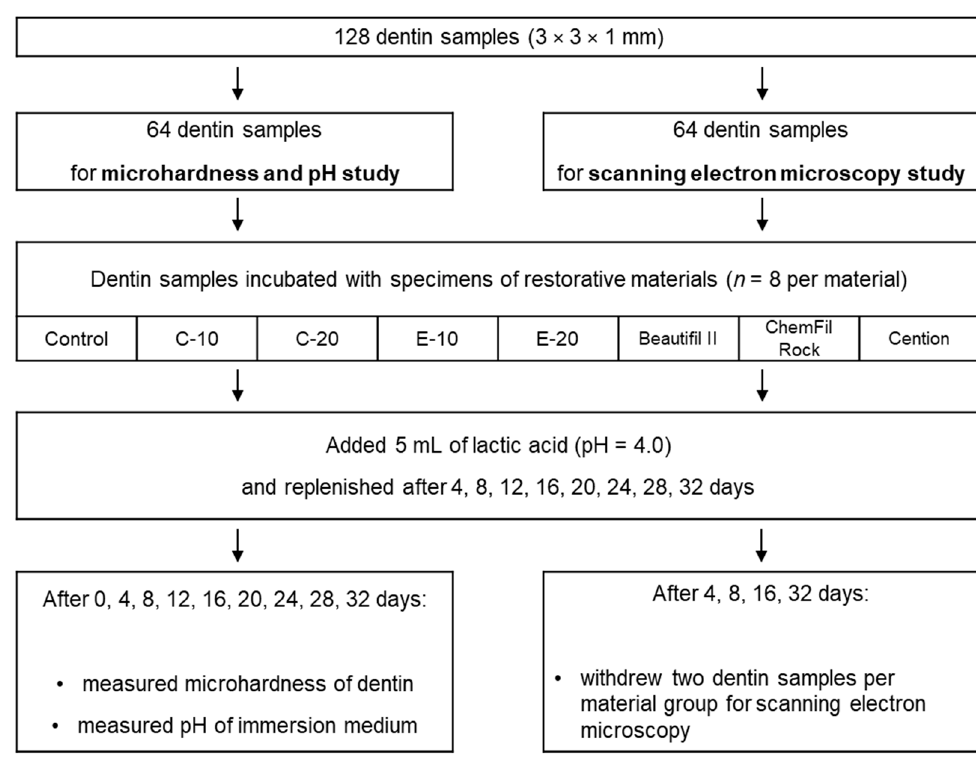
Figure 1. Flowchart of experimental design.